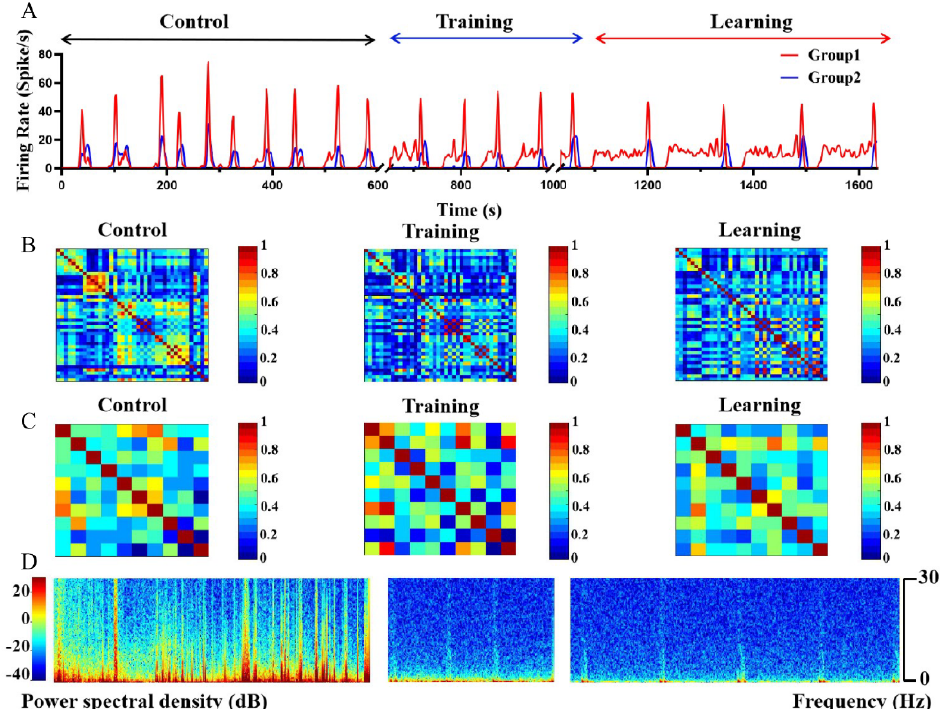
Figure 8. Electrophysiological changes at the network level to neurons cultured in vitro through training. ( A ) The overall firing rate of neurons in the two groups before, during, and after learning. ( B ) The synchrony index among Group 1 neurons before, during, and after training. ( C ) The synchrony index among Group 2 neurons before, during, and after training. ( D ) The power spectrogram of the three stages.